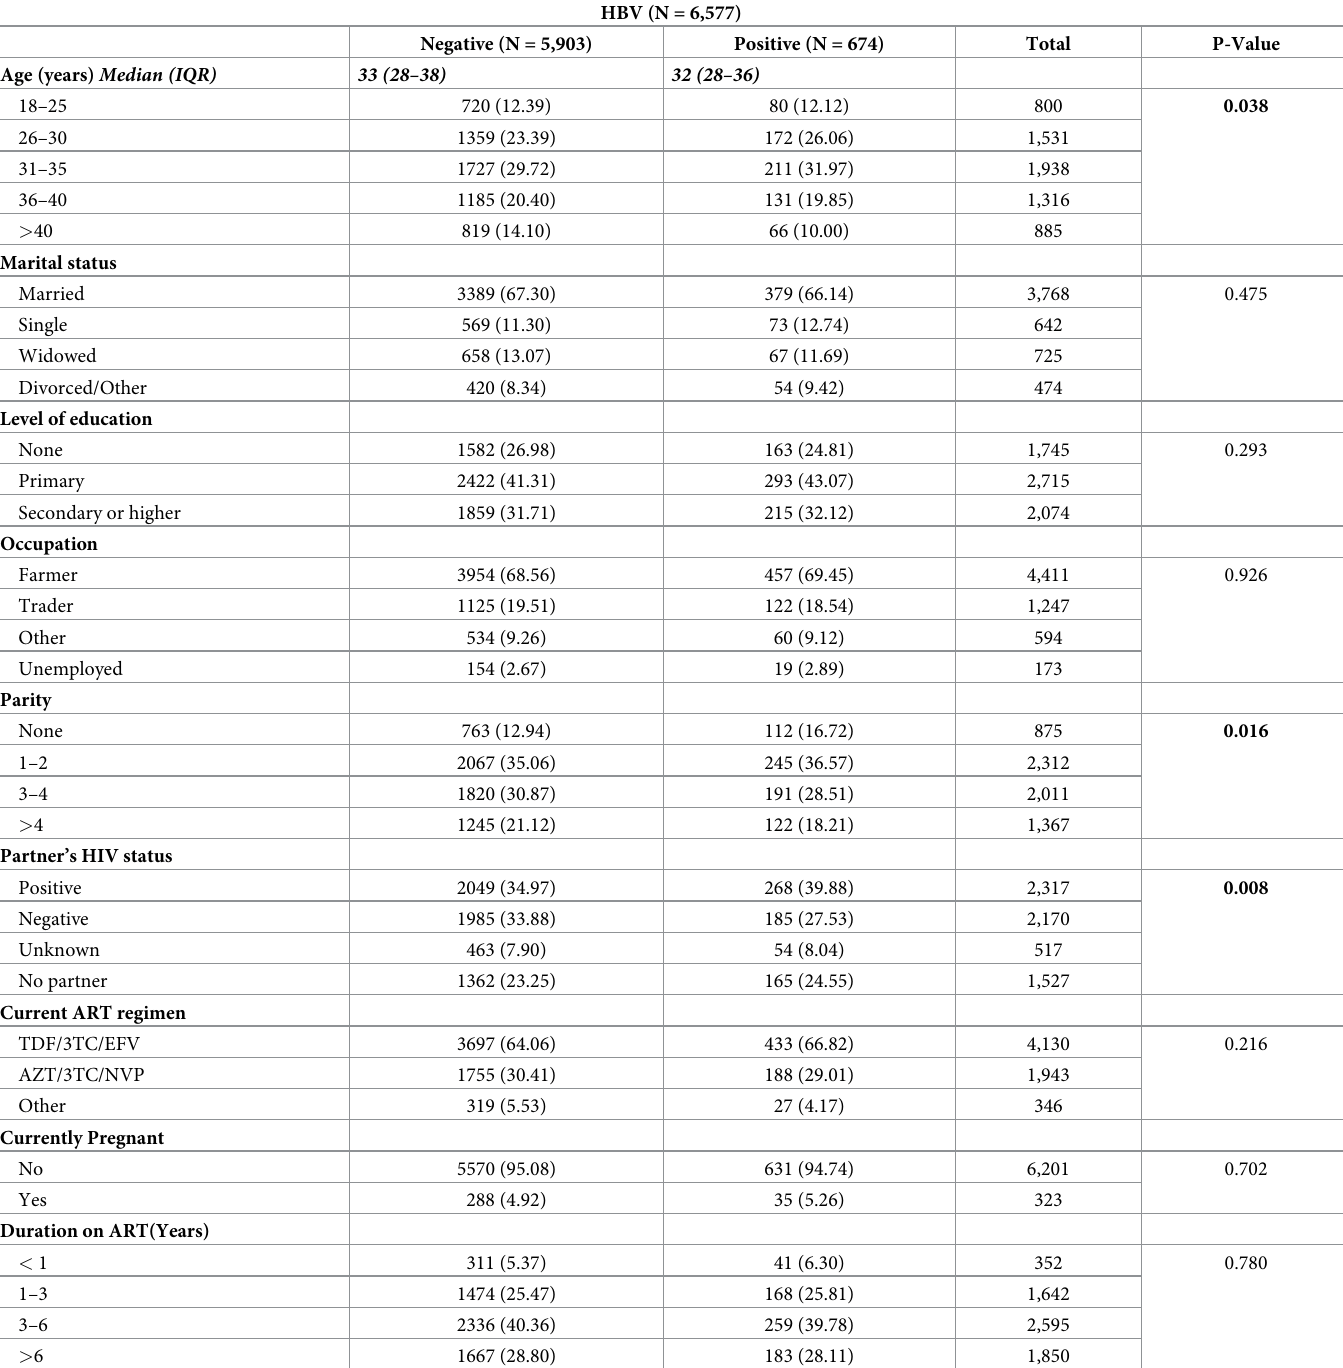
Table 2. Bivariable analysis of socio-demographic and clinical characteristics associated with HBV infection among female HBV testers and participants of patient- held smartcard scale-up study in Benue State,